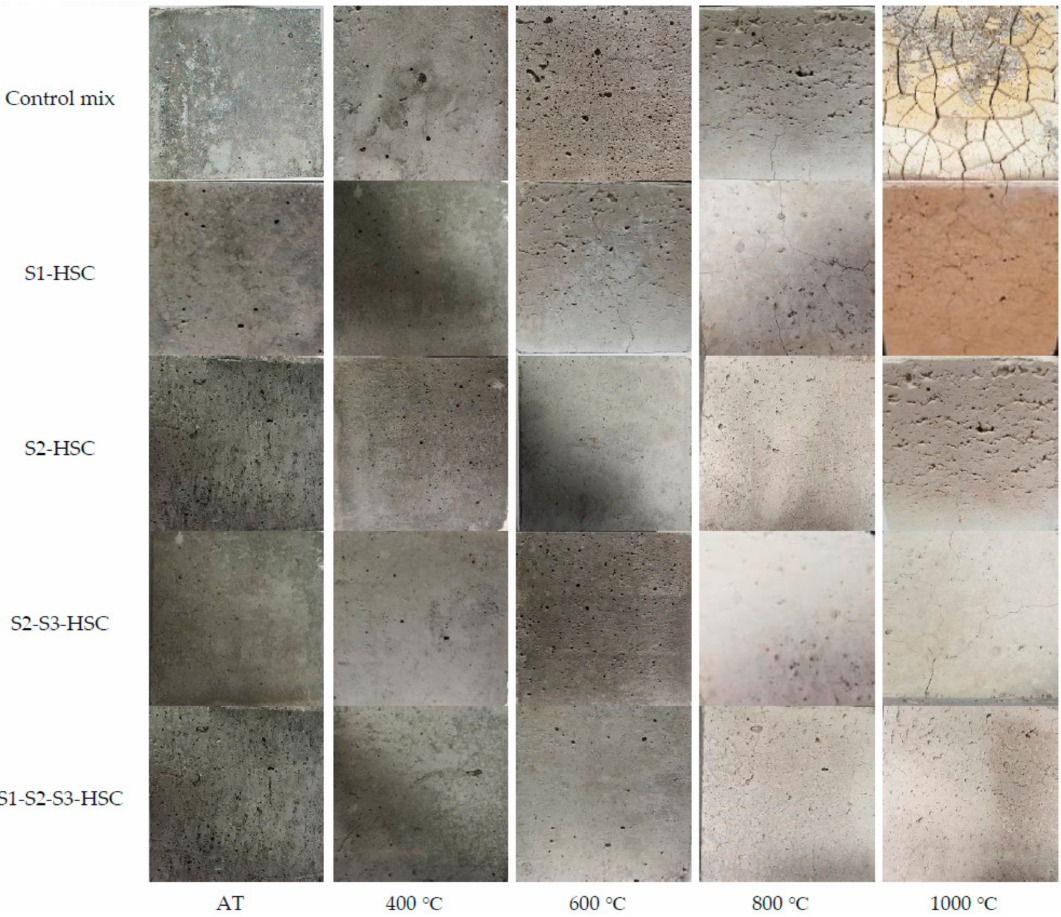
Figure 7. Appearances of specimen subjected to elevated